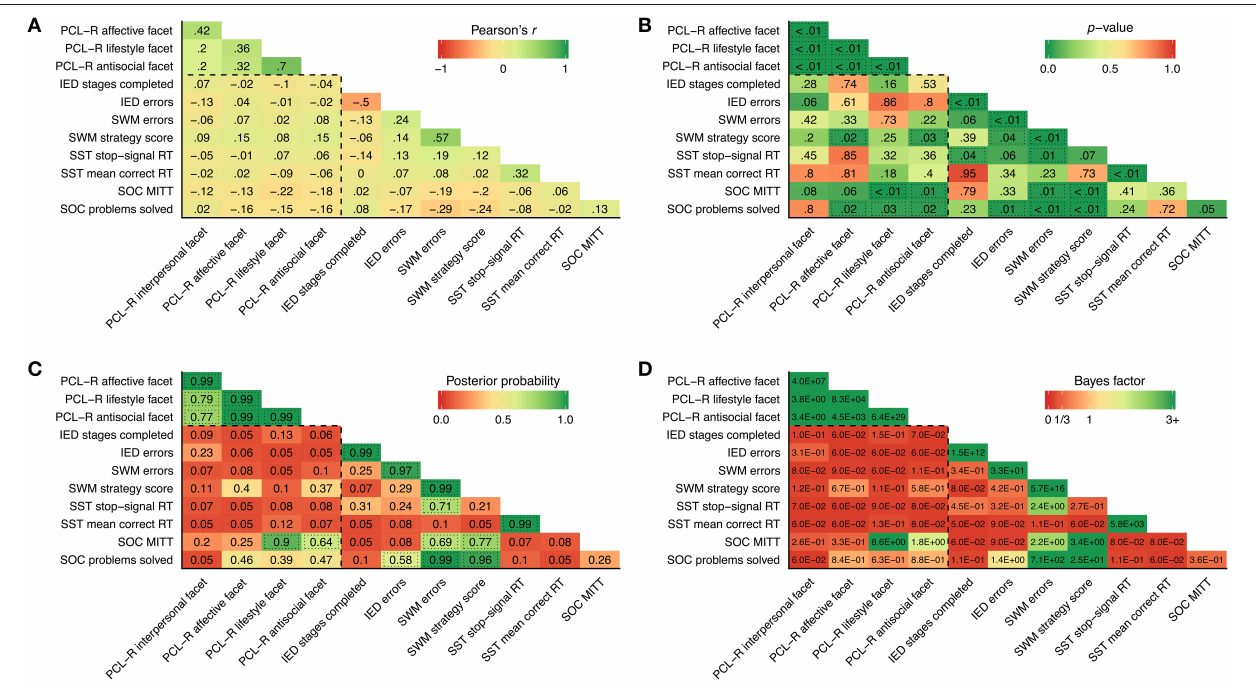
FIGURE 1 | (A–D) Zero-order correlations (Pearson’s r ), p -values, posterior probabilities and Bayes factors. The dashed box contains the primary study variables. Dotted lines indicate statistical significance at p < 0.05 (B) or a posterior probability > 0.50 (C) . PCL-R, Psychopathy Checklist-Revised; IED, Intra/Extra- Dimensional Shift; SWM, Spatial Working Memory; SST, Stop-Signal Task; RT, reaction time; SOC, Stockings of Cambridge; MITT, Mean initial thinking time.